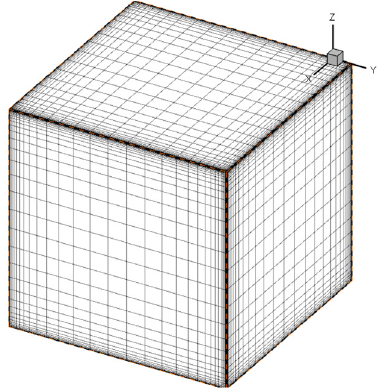
Figure 3. Grid system employed in the calculation.